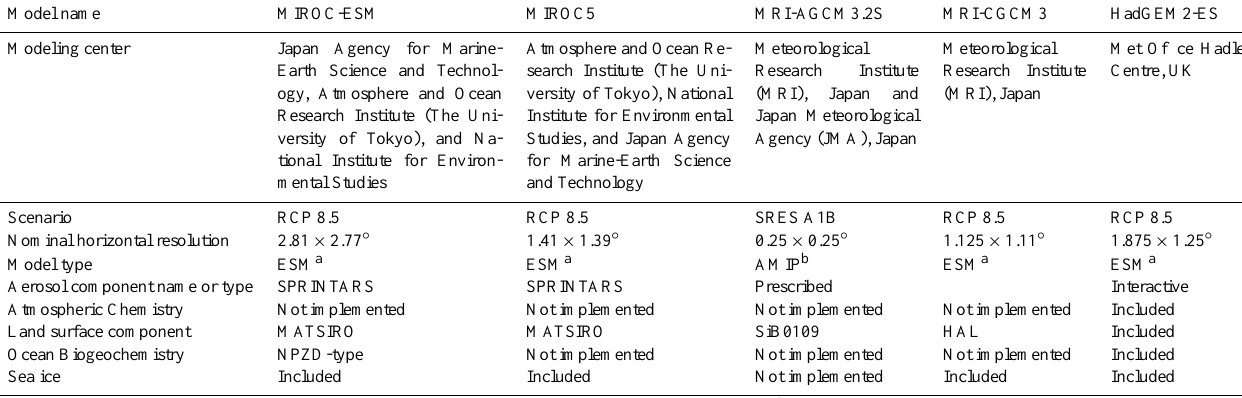
Table B1. Salient features of CMIP5 climate models used in the